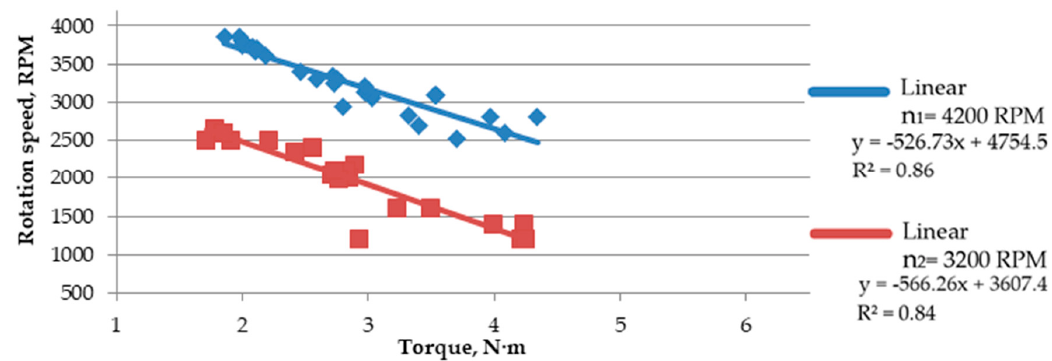
Figure 9. The dependence of rotation speed to torque for Miscanthus × giganteus .